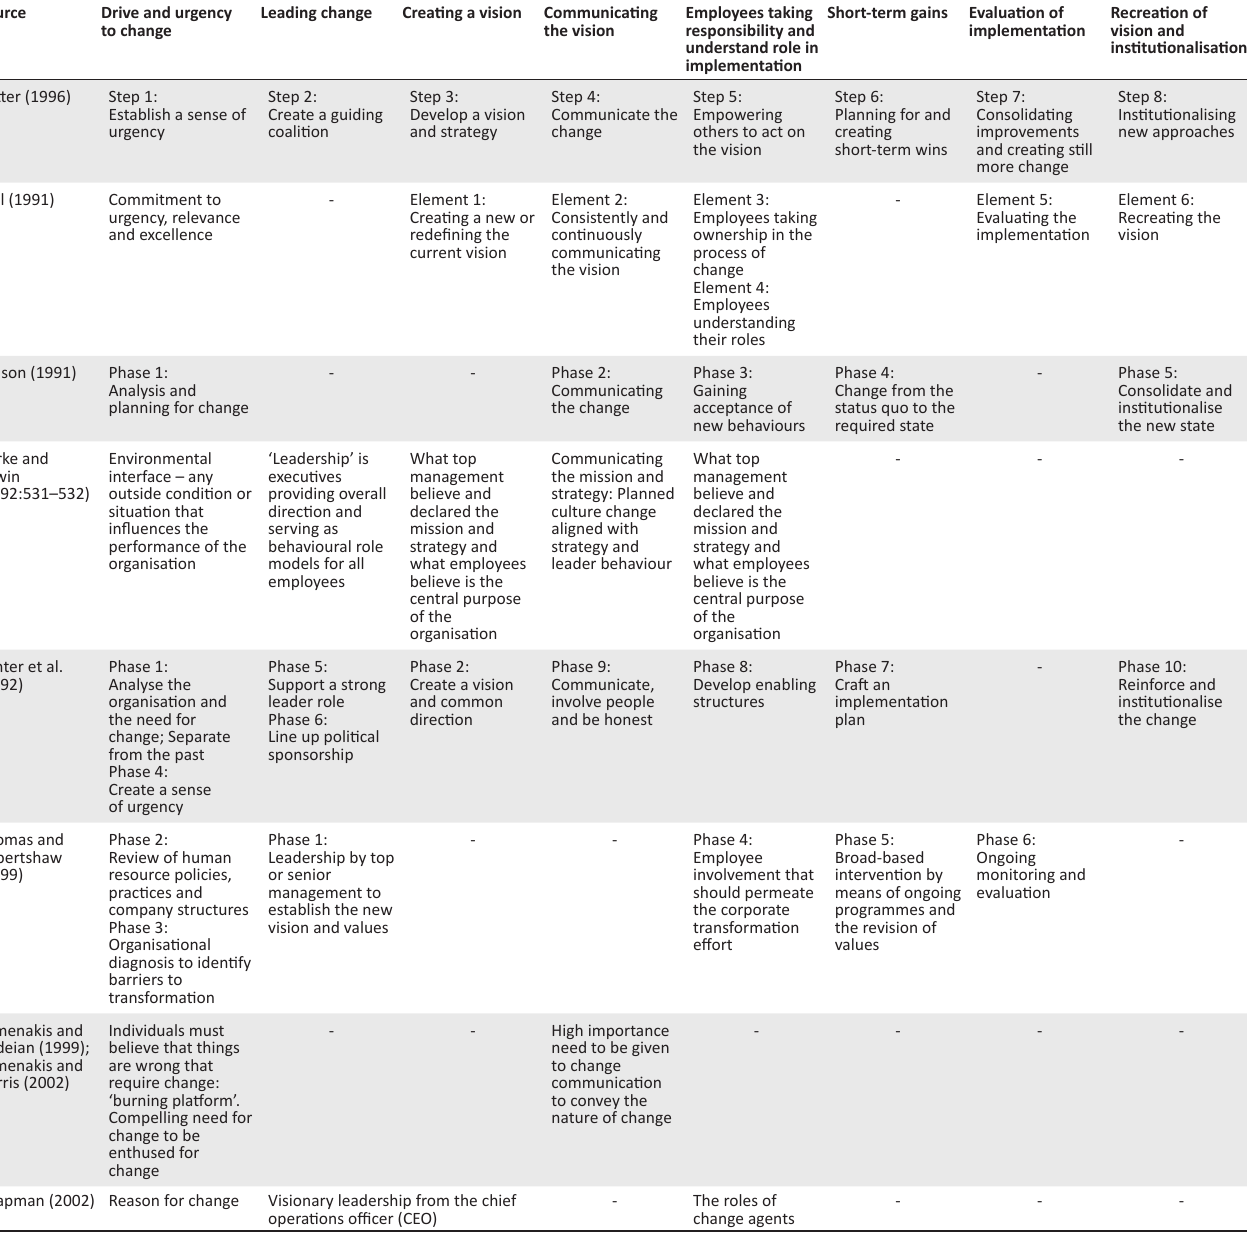
TABLE 1: A comparison of other change leadership elements with Kotter’s (1996) eight-step change leadership model. Source Drive and urgency Leading to change